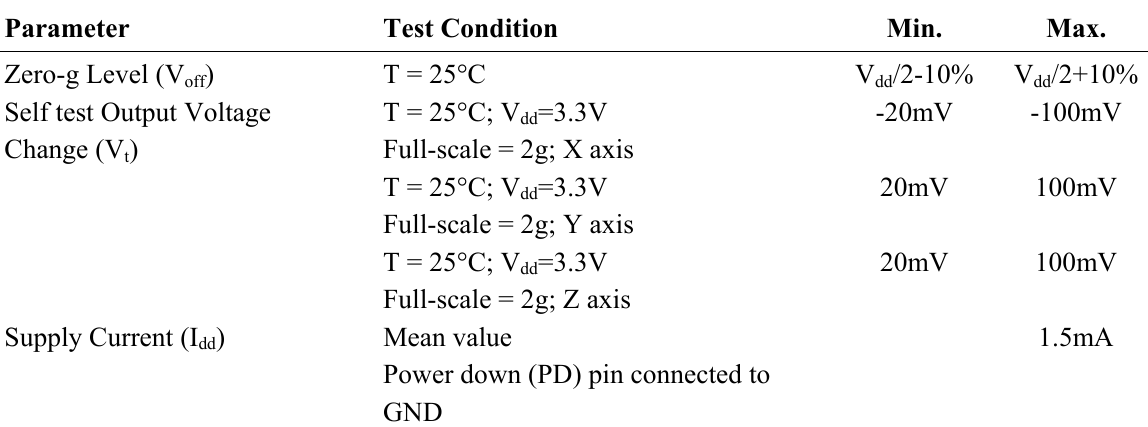
Table 3. Electrical parameters for initial, intermediate and final